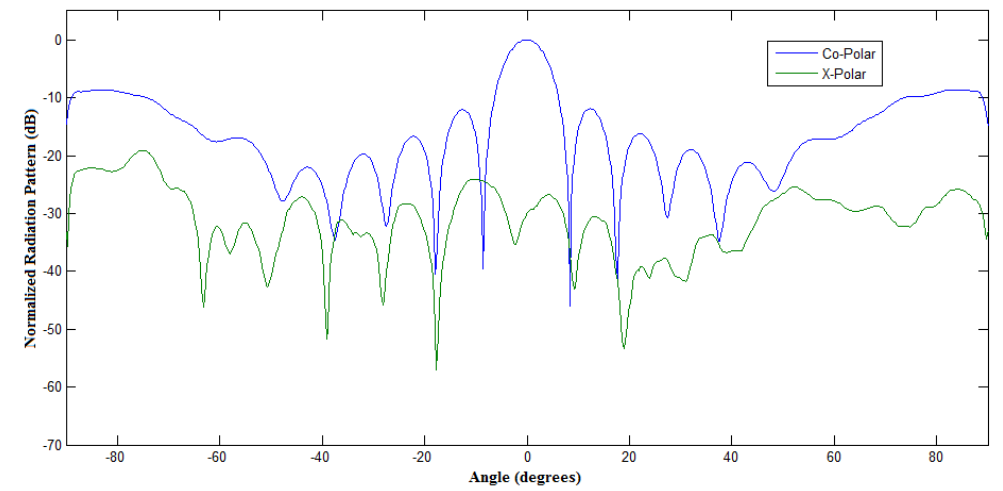
Figure 15. The azimuth principal plane cut of the measured co-polar and cross-polar magnitude patterns of an eight-by-eight faceted-cylindrical phased array antenna (based on AEPs and software